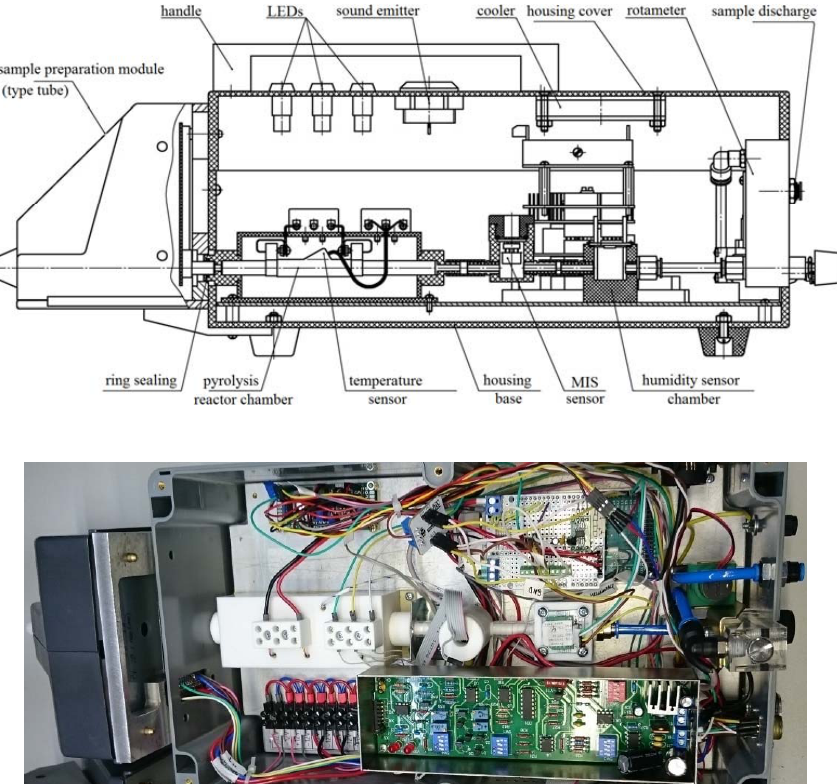
Figure 3. The draft and photograph of prototype detector of nitro compounds (measurement unit) with a sample preparation module for operation in the vapor registration mode. Overall dimensions of the measuring unit 530 × 210 × 200 mm (L × W ×